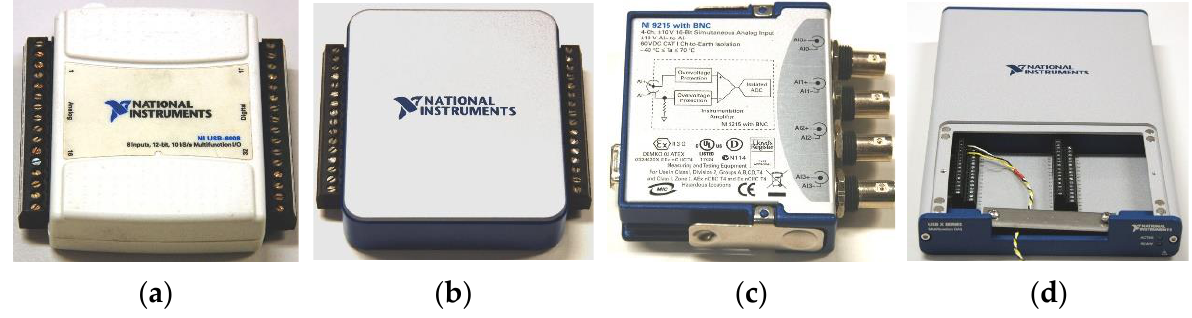
Figure 1. Measurement modules tested: ( a ) USB-6008; ( b ) USB-6001; ( c ) USB-9215; ( d ) USB-6341. Table 1. Parameters of tested measurement modules for ± 10 V differential